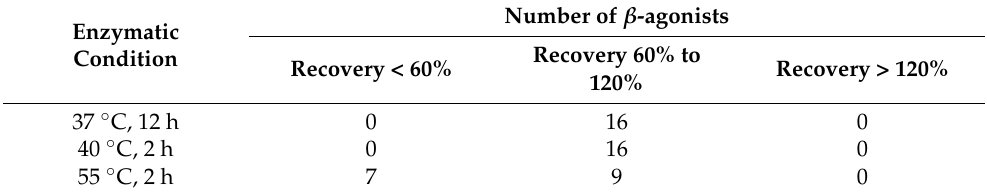
Table 2. Effect of enzymatic condition on the recovery of sixteen β -agonists.